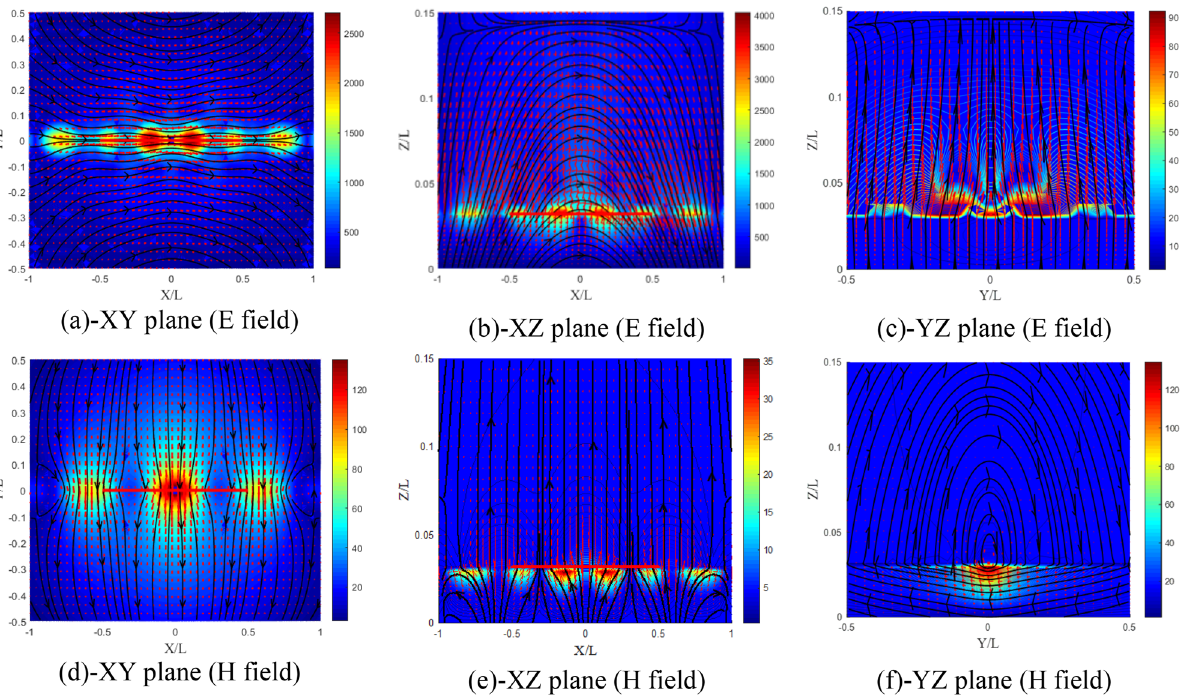
0.5 ) case, ( a – c ) electric and η xy = =